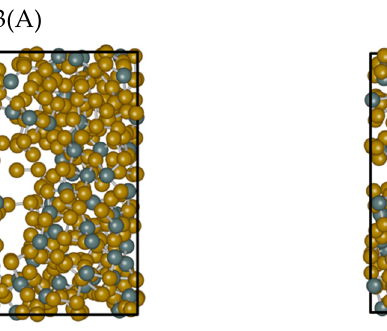
Figure 7. Snapshots of configurations obtained for liquid GeSe 4 at T = 1073 K by using the four different treatments for the inclusion of the dispersion forces detailed in the text. From top to bottom and from left to right: No-vdW ( top left ), D2 ( top right ), D3 (( bottom left ), first trajectory), MLWF ( bottom right ). The snapshots were produced by iRASPA [34]. The Ge atoms are in dark green, the Se atoms in brown, and the unit cell is represented with a black line.